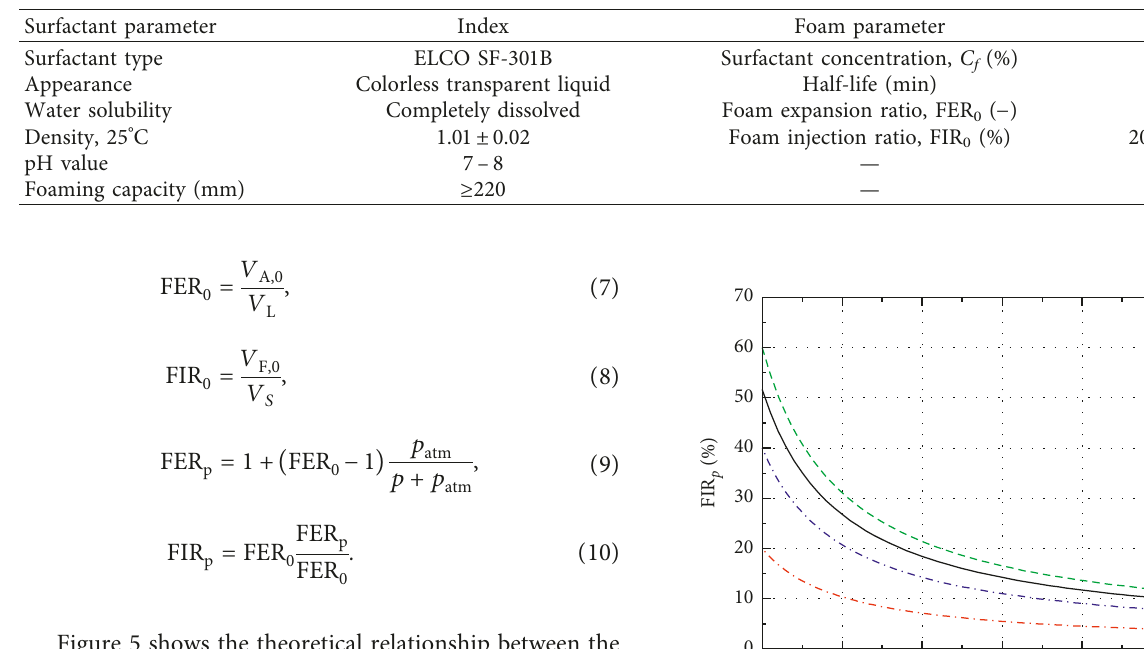
Table 1: Basic parameters of the surfactant and foam.